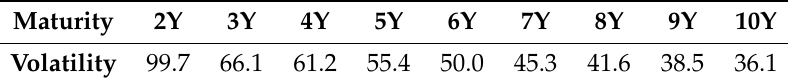
Table 1. 6 Month EURIBOR Mid Price ATM Volatilities